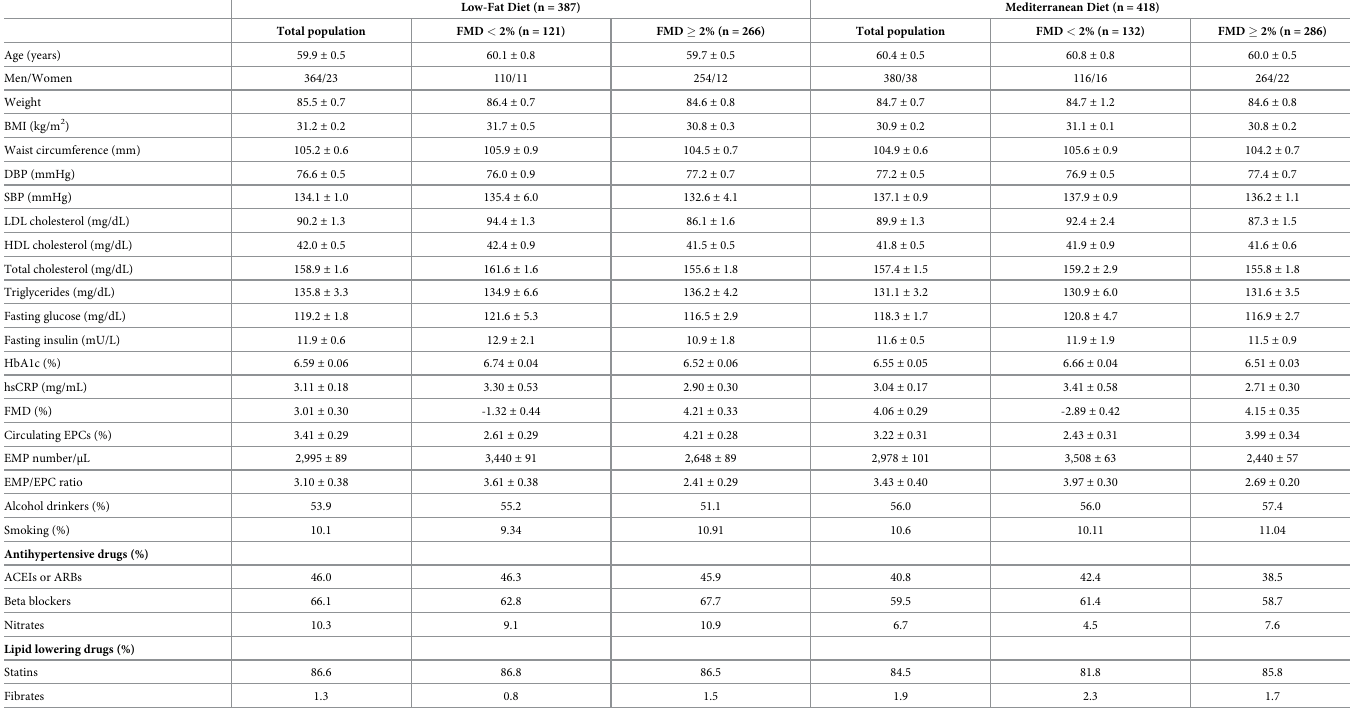
Table 1. Baseline characteristics of the total CHD patients and classified according to the severity of endothelial dysfunction 1,2